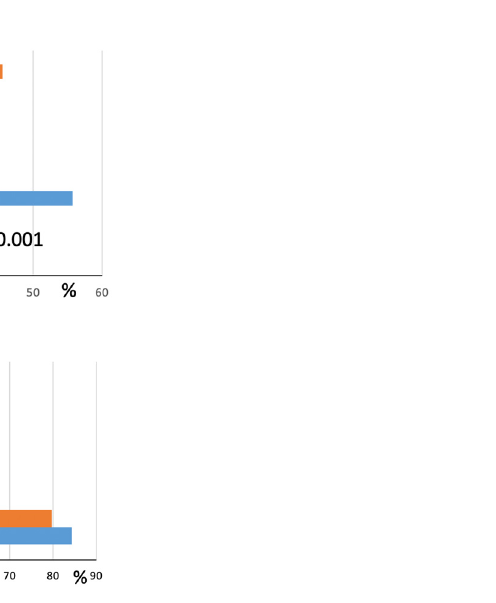
Figure 2. Distribution of hand washing per day ( a ) and wet time ( b ) in 1st-year and 2nd–3rd–year students.